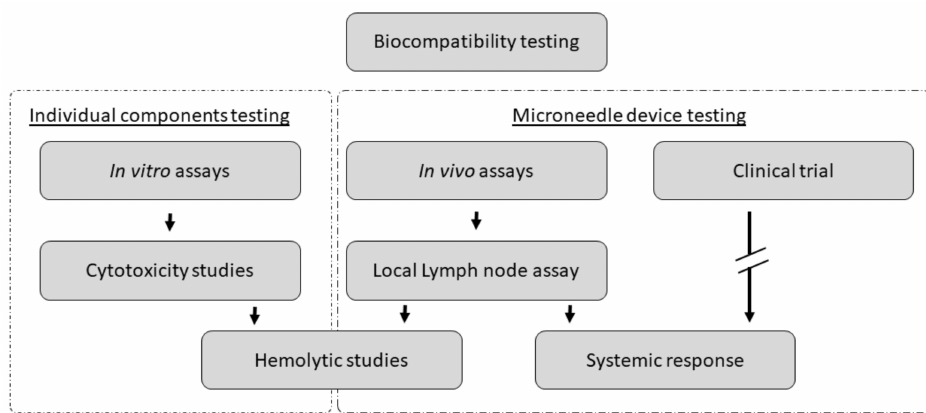
Figure 2. Schematic diagram showing the biocompatibility assessment process. Individual components of the MNs are tested for cytotoxicity or haemotoxicity by in vitro assays. In vivo assays test the whole device for any systemic responses and LLNA in addition to the haemocompatibility assays. The final stage of testing is the clinical trial, where all the reactions and toxicity are studied before accepting the MN device for general